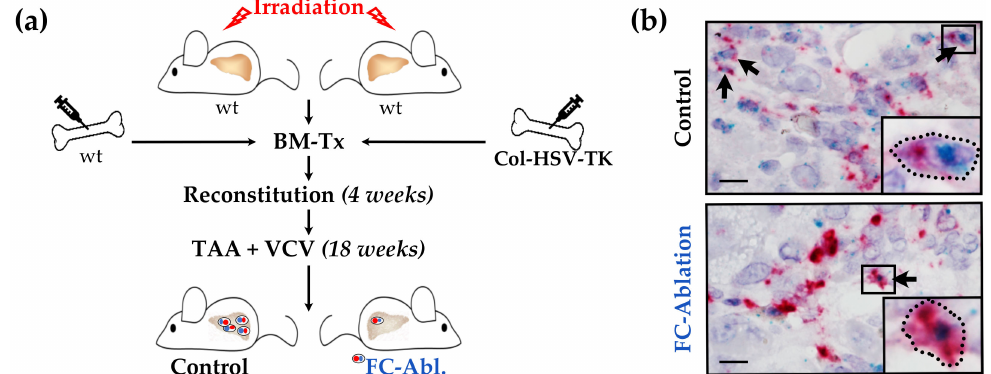
Figure 1. Suicide gene strategy enabled fibrocyte depletion. ( a ) Schematic representation of the animal experiments including lethal irradiation, bone marrow transplantation (BM-Tx), and treatment with valganciclovir (VCV) and thioacetamide (TAA). While TAA induces hepatic fibrosis, VCV is metabolized into toxic compounds by all cells expressing herpes simplex virus thymidine kinase (HSV-TK). ( b ) Successful depletion was confirmed by RNA in situ hybridization. Fibrocytes (FC, black arrows) were identified by the simultaneous expression of Col1a1 (red) and Ptprc (CD45, blue) transcripts. The details in boxes were enlarged in individual panels in the lower right part of the micrograph. Note that individual and possibly Col1a1 / Ptprc co-expressing cells were detected in the fibrocyte-ablated group. Magnification 1000 × , bars 10 µ